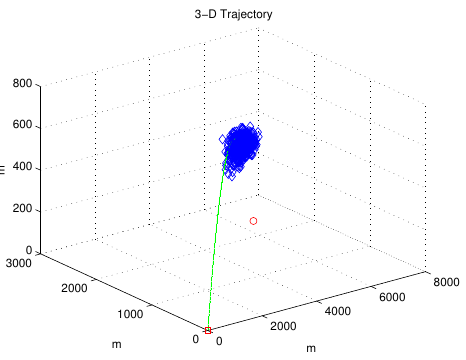
Figure 2. Simulation result using var ψ = 0.5 degree, var θ = 0.5 degree, and var V = 0.1